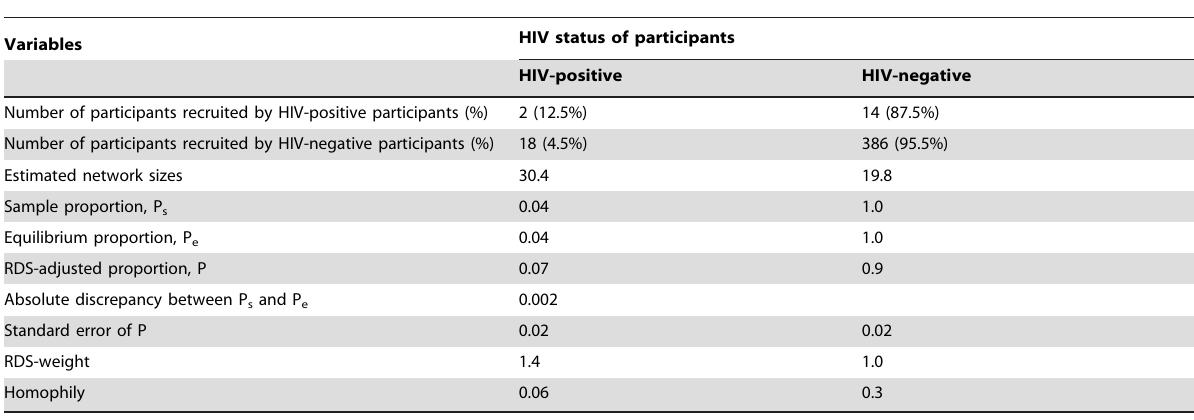
Table 2. Reported rates and status of HIV testing among MSM, in Nanjing, China, 2008 (n=420 * ).